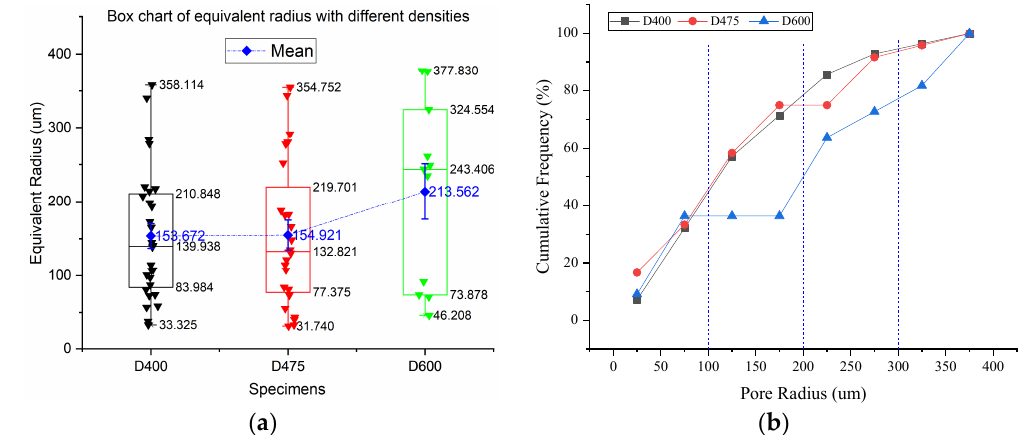
Figure 8. Box chart and cumulative frequency analysis of Equivalent radius. ( a ) Box chart of equivalent radius. ( b ) Cumulative frequency of pore radius.